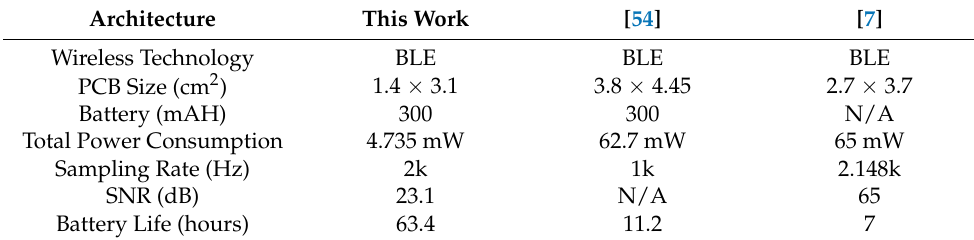
Table 2. Comparison of various surface EMG hardware